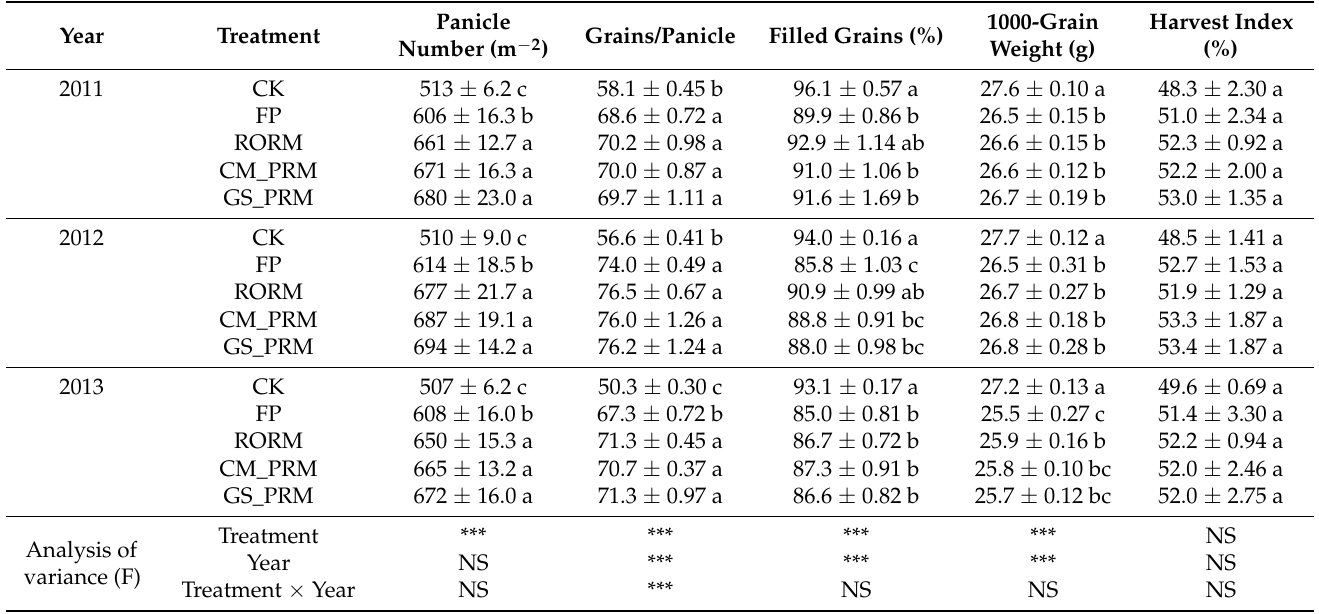
Table 1. Average values ± standard deviations of grain yield components obtained in different rice management systems with rice variety Kongyu 131 from 2011–2013.